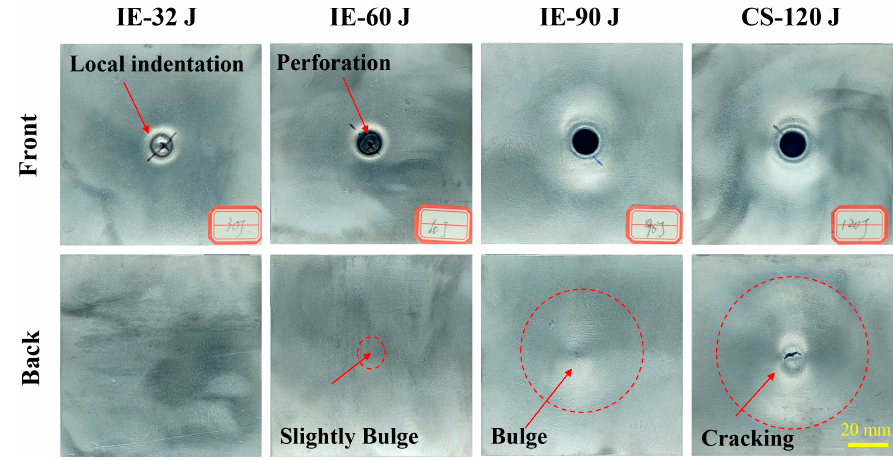
Figure 5. Failure modes of panels of AFS under different impact energy.